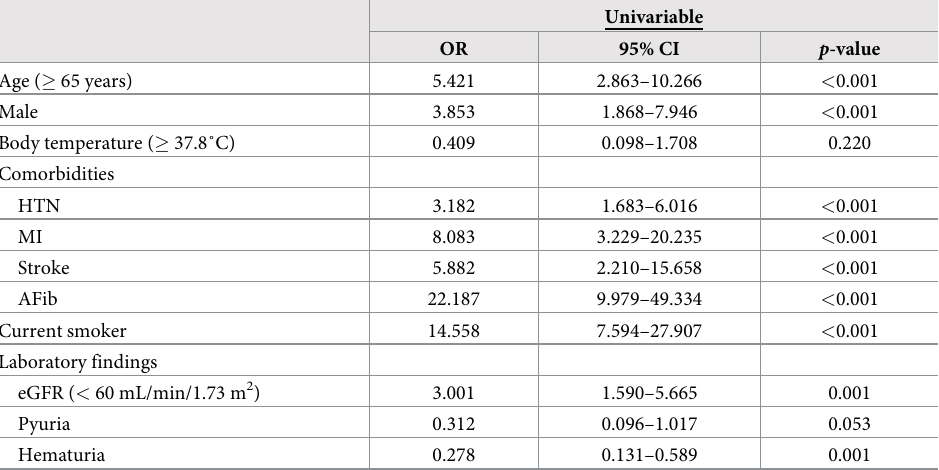
Table 2. Univariable logistic regression analyses of predictors of renal